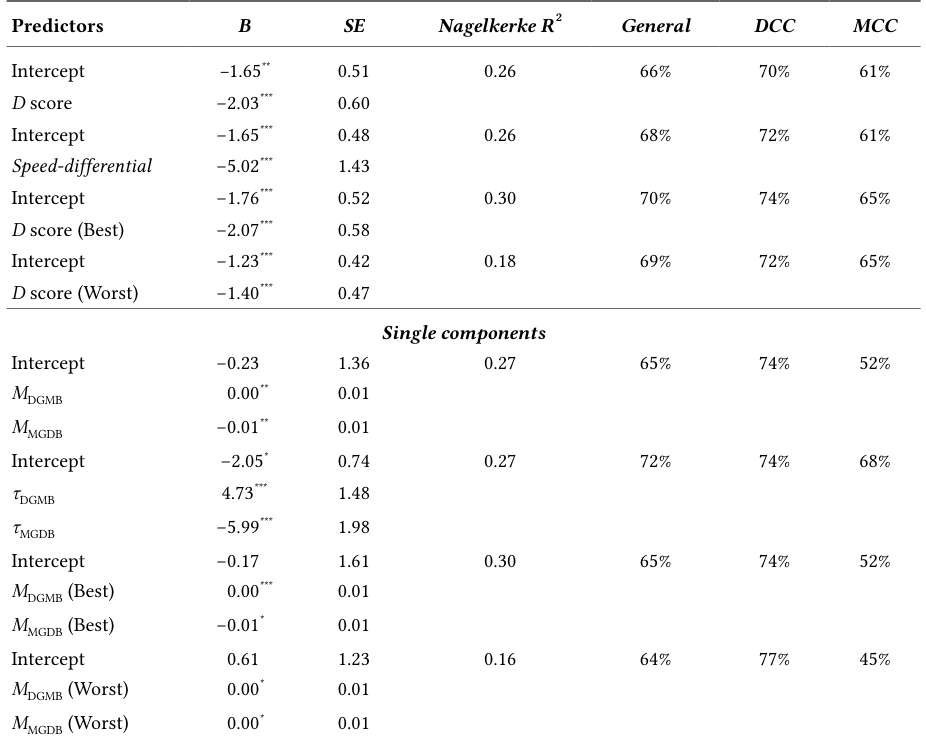
Choice Prediction: Models Resulting After Backward Deletion